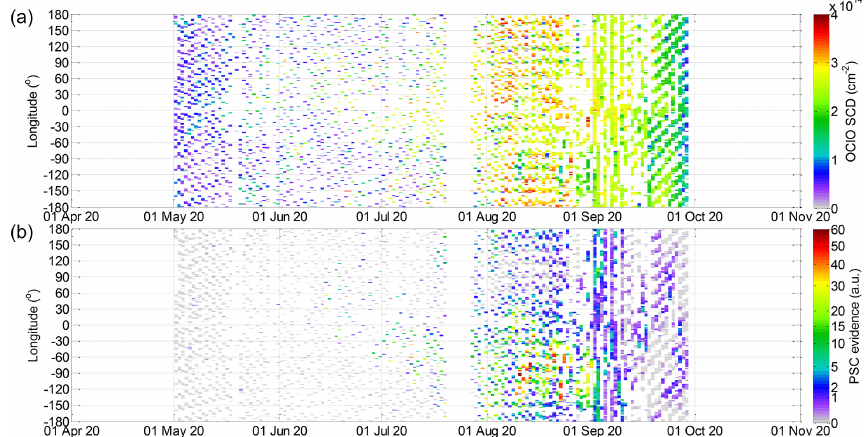
Figure A5. Same as Fig. 18a and b but with the assumed measurement location coordinate shifted by 100km from the line-of-sight coordinate towards the